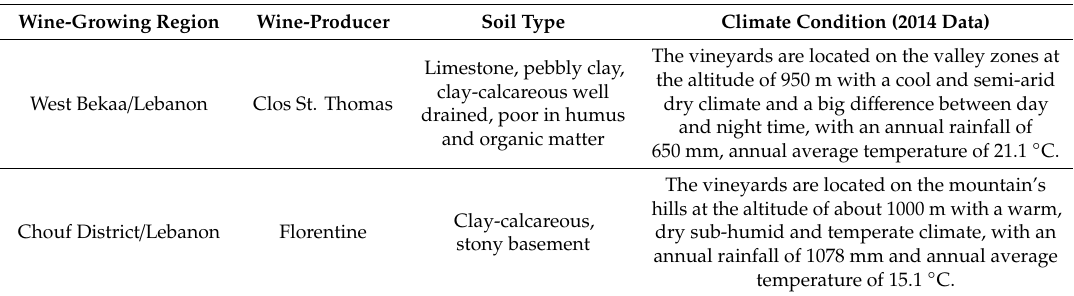
Wine producer, regional climate condition and soil type from the two di ff erent wine-growing regions.